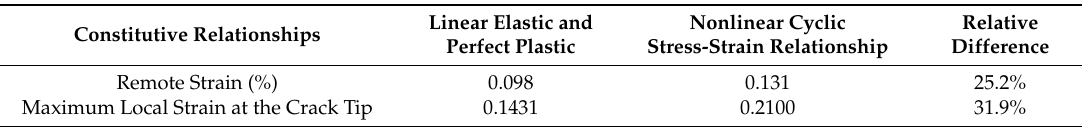
Table 2 . Comparison between the different constitutive relationships. Table 2. Comparison between the different constitutive